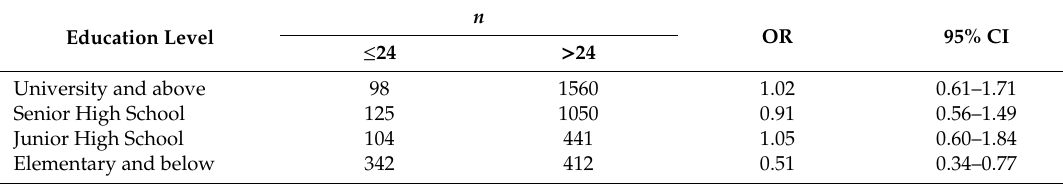
Table 4. E ff ect of sex on MMSE scores with respect to educational level.